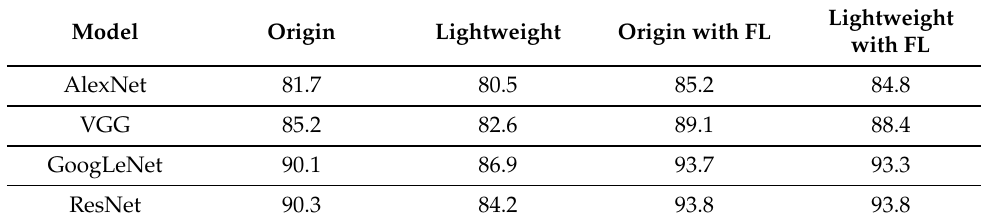
Table 6. Accuracy of original models and lightweighted models without federal learning (FL).